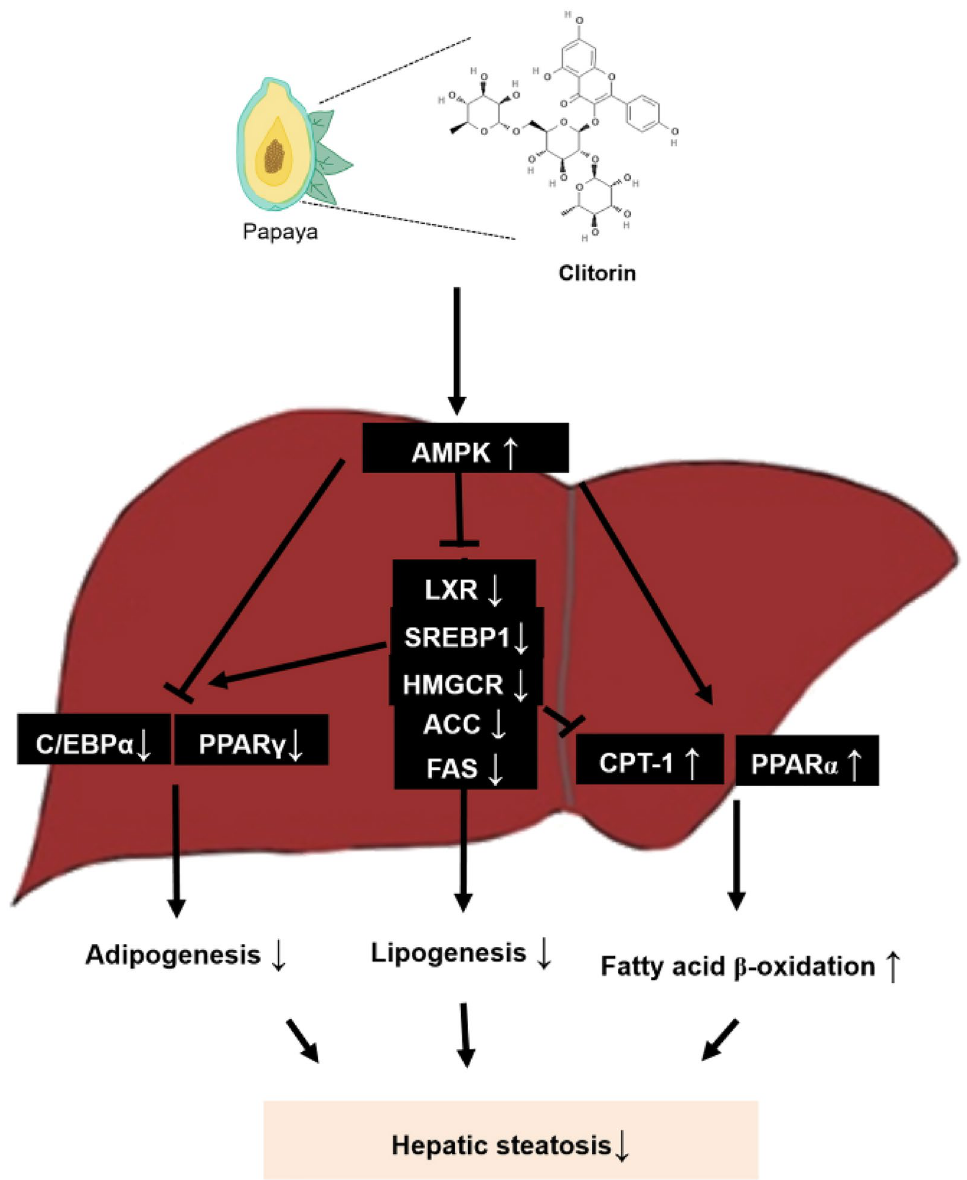
Figure 6. Schematic diagram of clitorin on prevention of WD-induced hepatic steatosis. Clitorin alleviated hepatic steatosis by reducing both adipogenesis and lipogenesis, and enhancing fatty acid oxidation in vivo and in vitro